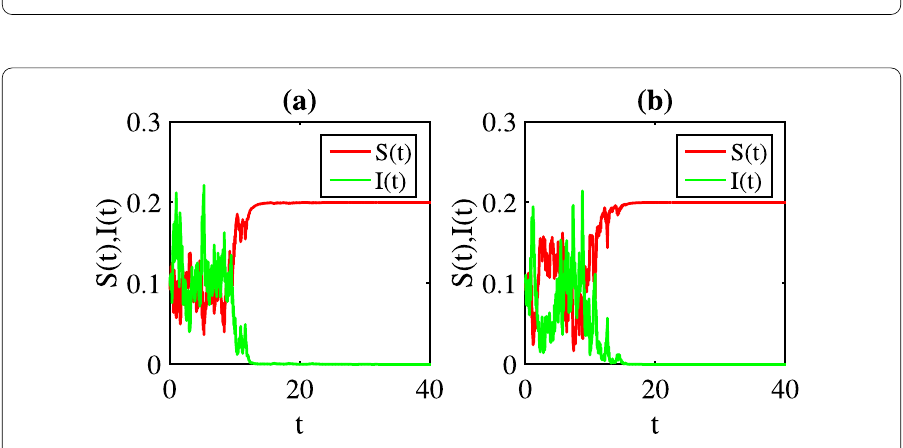
Figure 2 Time sequence diagram of stochastic system (7): ( a ) case (ii) of Theorem 2.1, ( b ) case (iii) of Theorem 2.1